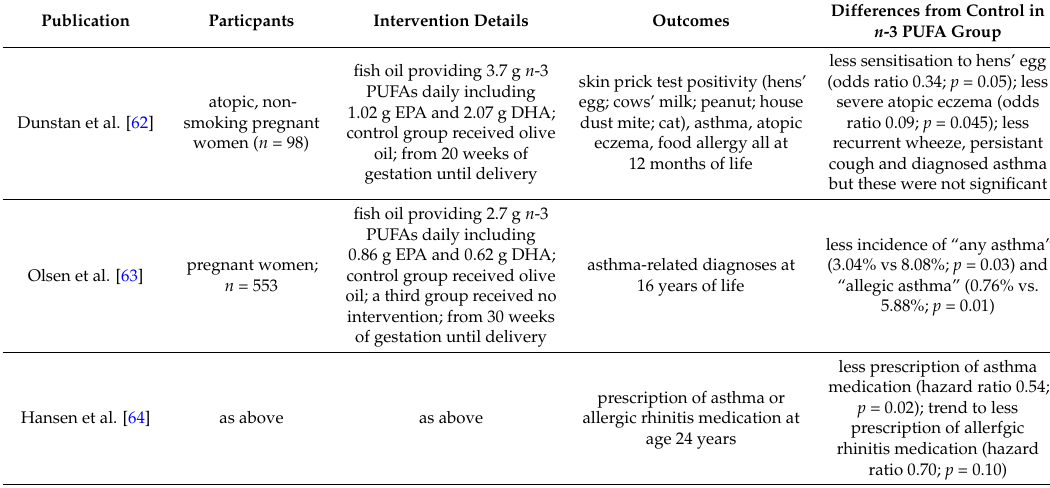
Table 1. Summary of randomized controlled trials of n -3 PUFAs in pregnancy reporting on allergic outcomes in the